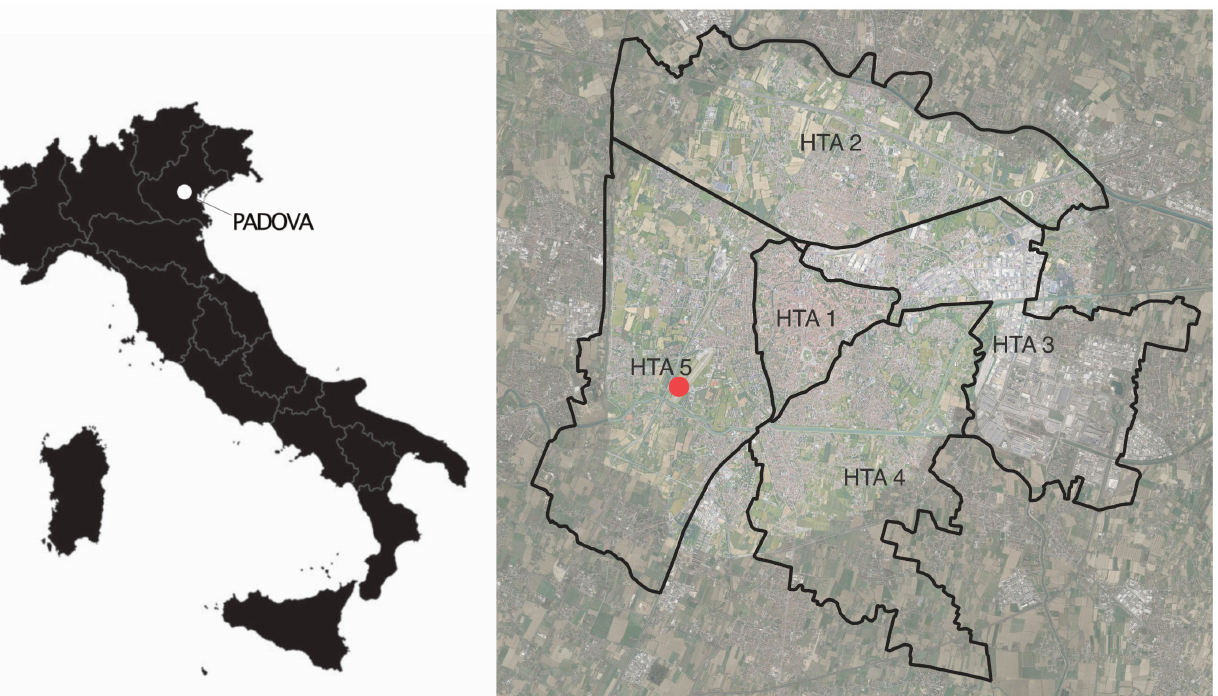
Figure 1. Geographical framework of the study area with the five homogeneous territorial areas (HTAs) into which the Municipality of Padova is subdivided. The red dot indicates the location of the reference weather station.